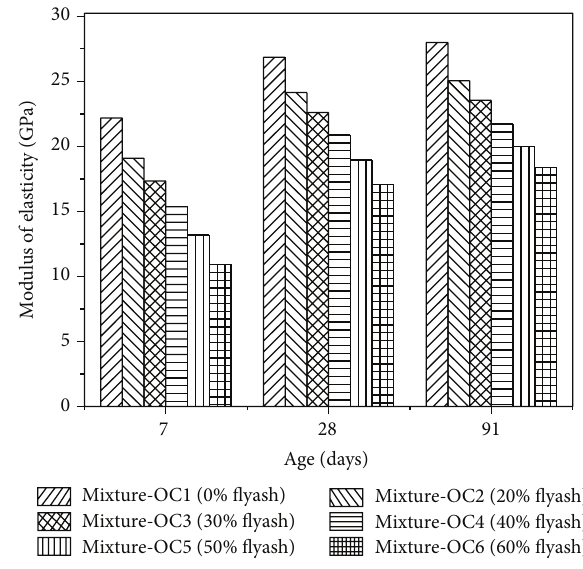
Figure 4: Modulus of elasticity versus age.